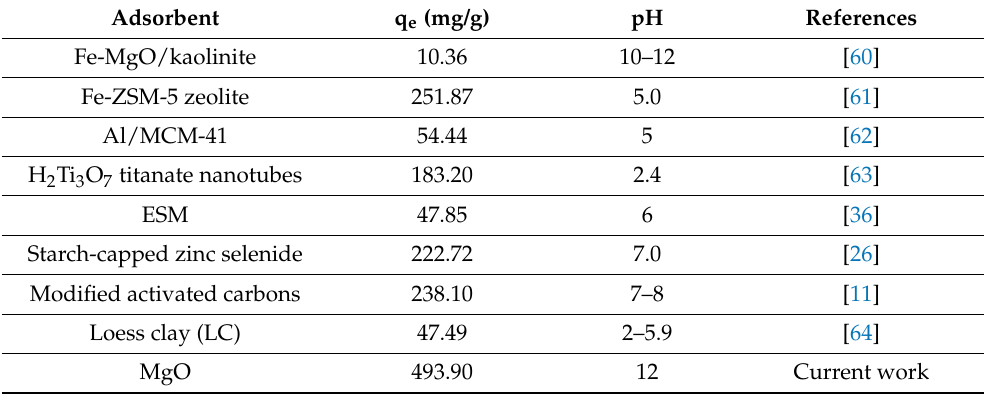
Table 3. Comparison of the adsorption capabilities of MgO nanorods with various adsorbents.